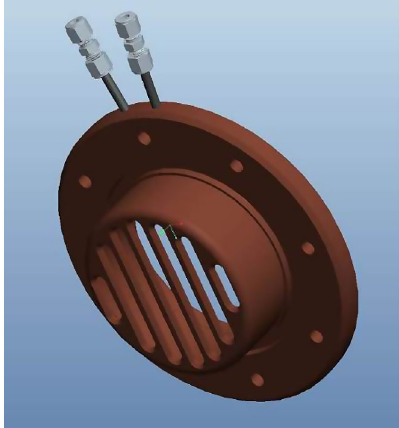
FIG. 8. 3D model of the water-cooled ‘‘vacuum